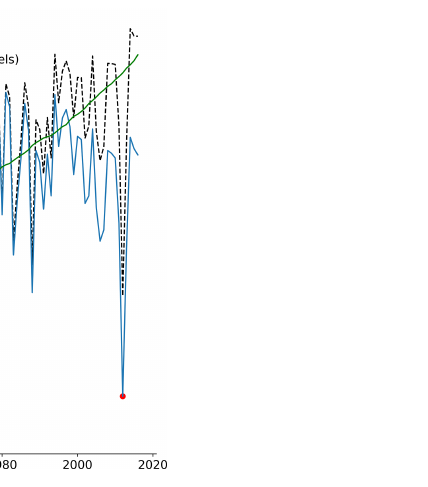
Figure C3. Time series of averaged US soybean yields for the selected area (dotted black line) and its detrended counterpart (blue). The 2012 season is highlighted in red. The regression trend based on the global CO 2 levels that is used to detrend the soybean yields is shown in green.